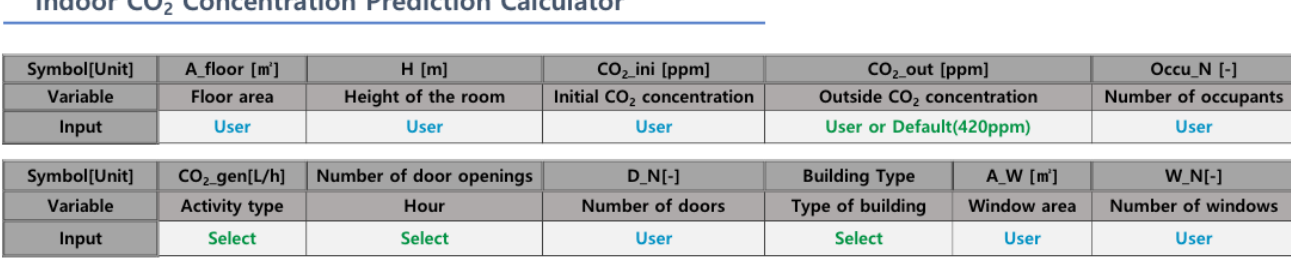
2 concentration prediction